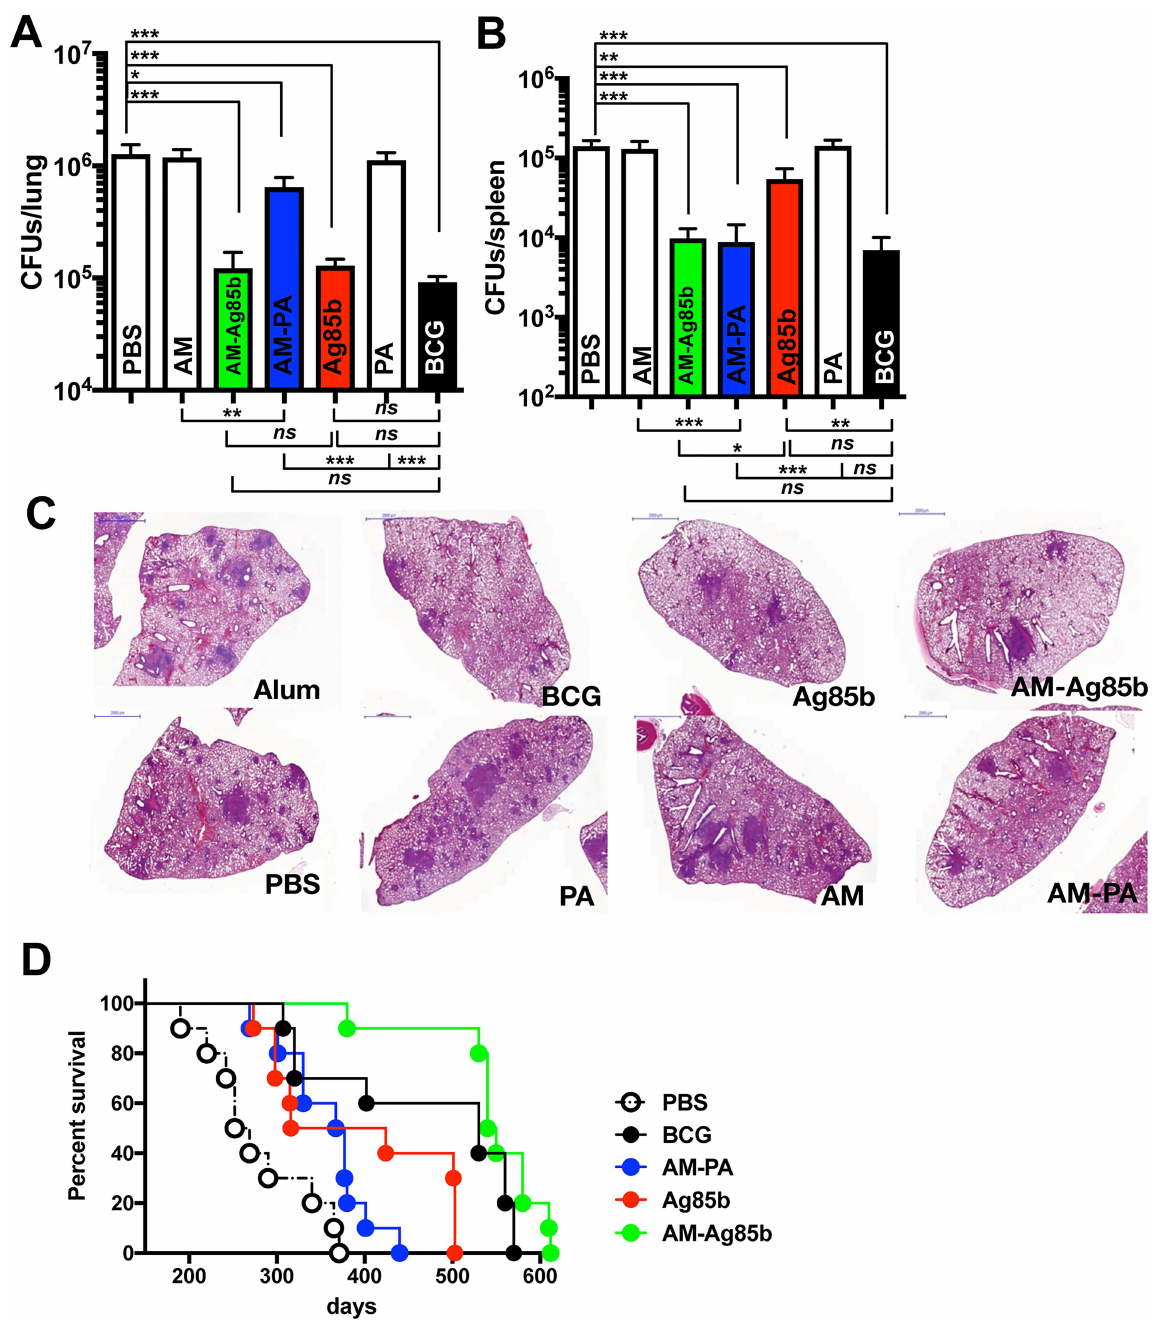
Fig 4. Immunization with conjugates protect against Mtb infection. (A,B) Bacterialload (CFUs) in the lungs (A) and spleen (B) of individualC57BL/6mice, immunized with the indicatedpreparations was determined at 4 weeks after infection with a low dose of Mtb H37Rvvia aerosol(approx. 100CFUs). The results are pooledvaluesfrom two similarand independentexperiments. Experimental groups used5 mice. ( * P < 0.05, ** P < 0.01 *** P < 0.001, one-wayANOVA with Tukey post-test). (C) Representative H&E staining imagesfrom lungsof C57BL/6mice immunizedwith the indicatedpreparations and aerosolinfected with Mtb H37Rvfor 4 weeks. A representative lung section for eachtreatment is shown. (D) Survival of mice immunized with PBS ( n = 10), 1 × 10 6 CFU of BCG ( n = 10), 10 μ g of AM (Mtb)-Ag85b( n = 10), 10 μ gof AM (Mtb)-PA conjugate( n = 10) or 1 μ gof Ag85b( n = 10) andchallenged with ~100 CFU of aerosolized Mtb H37Rv. All the immunizedmice were significantly differentfrom that of PBS-treated mice ( P < 0.001, log- rank test for AM-Ag85b andBCG; P = 0.0064, log-ranktest for Ag85b). No differences betweenthe immunized groupswere found except for Ag85bvs AM-Ag85bimmunizedmice ( P = 0.0166). The survival curve for AM(Mtb)-PA was significantly different from that of PBS ( P = 0.049, Gehan-Breslow-Wilcoxontest; P = 0.057, log-ranktest). Survivalstudieswere performedtwice with similar results.